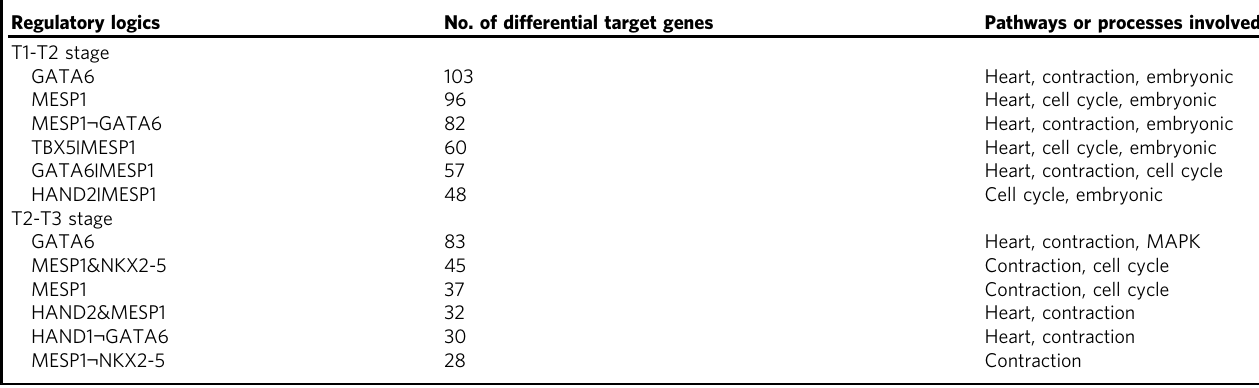
GATA4/6, HAND2, TBX5, and NKX2-5 control transcription of